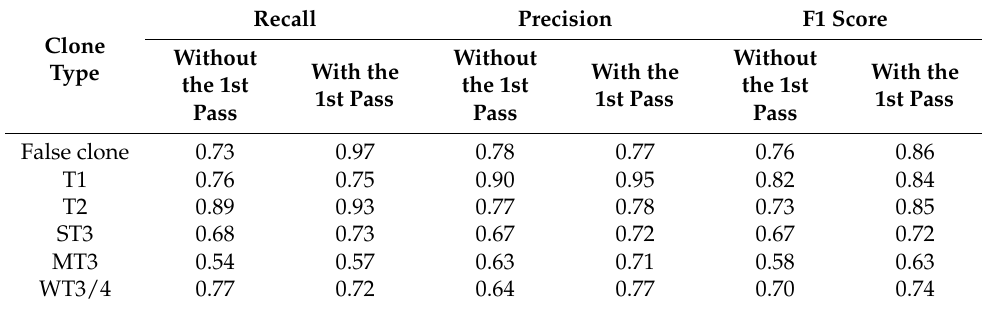
Table 5. Comparing clone classification achievements with/without the 1st pass.